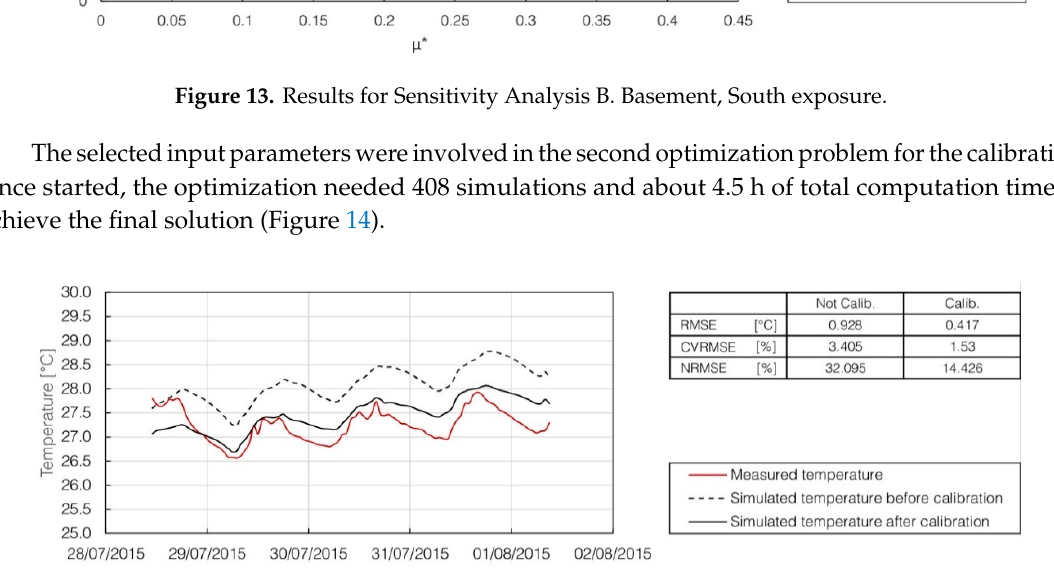
Figure 14. Results for Calibration B. Basement, South exposure.